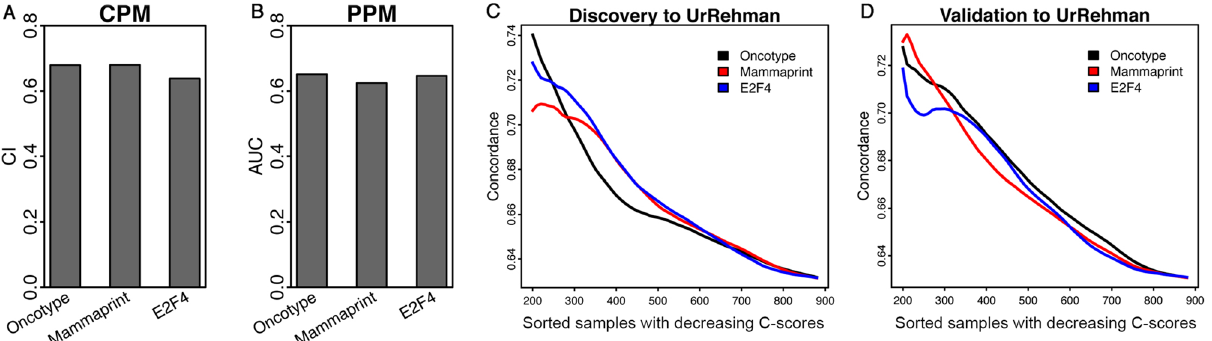
Figure 6. Applying the CPM/PPMs trained from the Curtis data to the Ur-Rehman data. ( A ) The overall concordance indexes (CI) of recurrence-free survival prediction models based on the Oncotype DX, the MammaPrint, and the E2F4 score, respectively. ( B ) The prediction accuracy (AUC) of the corresponding PPMs. ( C ) Application of models trained from the Curtis discovery data. ( D ) Application of models trained from the Curtis validation data. For each patient a prognostic score ( P -score) and a confidence score (C-score) were predicted by the CPM and the PPM, respectively. Patients were sorted in the decreasing order of their C-scores, and the average concordance of the CPM in the top N patients were calculated from N = 1 to all patients. The curve was smoothed by averaging values within a sliding window of size